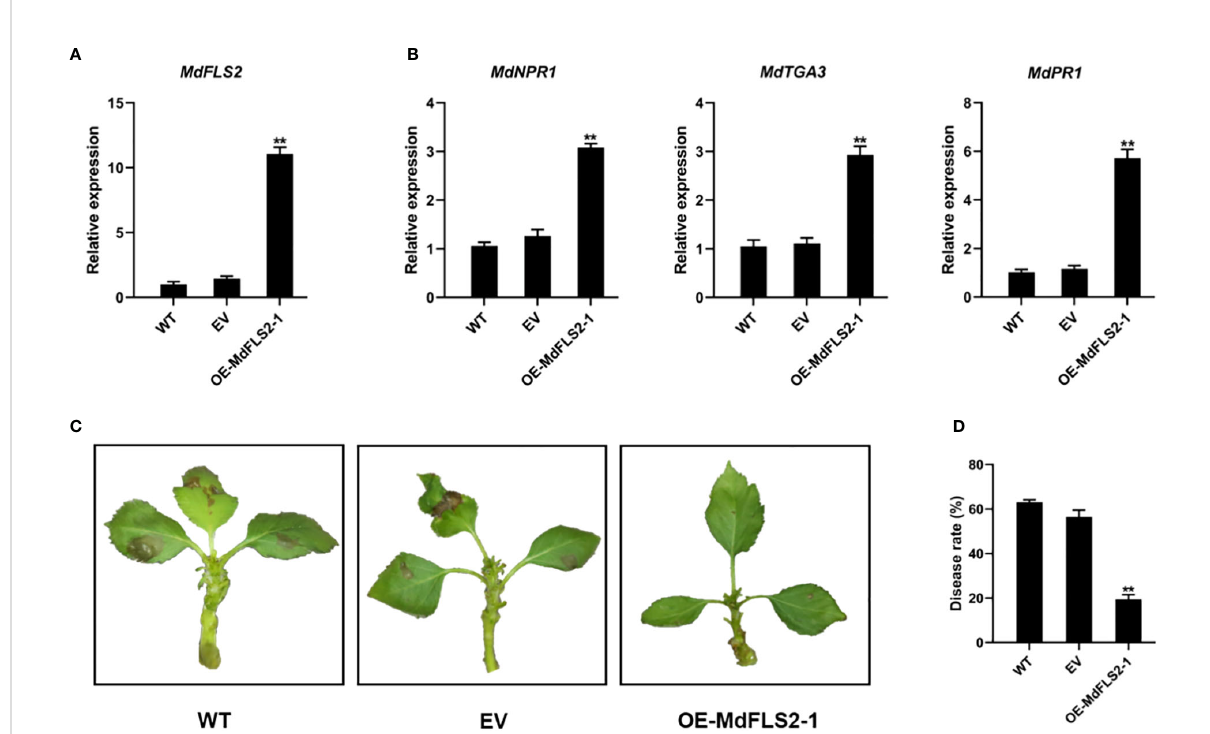
FIGURE 6 MdFLS2-1 positively regulates resistance of apple to AAAP. RT-qPCR analysis of the expression level of (A) MdFLS2 and (B) salicylate pathway marker genes MdNPR1, MdTGA3, and MdPR1 in leaves of WT, EV, and OE-MdFLS2-1 plants. Asterisks denote Student ’ s t-tests, signi fi cance: **P < 0.01. The mean ± SD of biological triplicates were taken for every value. (C) Symptoms of infection in leaves of WT, EV, and OE-MdFLS2-1 plants at 48 h after AAAP inoculation. (D) Incidence statistics of leaves of WT, EV, and OE-MdFLS2-1 plants at 48 h after AAAP inoculation. Values are the means ± SD of three biological replicates (Student ’ s t-tests, **P <